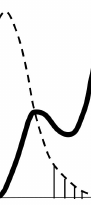
Figure 6. The assumed proton density distribution (dotted curve) at d O ··· O < 2.6 Å. The region of the proton density spread into the adjacent well is